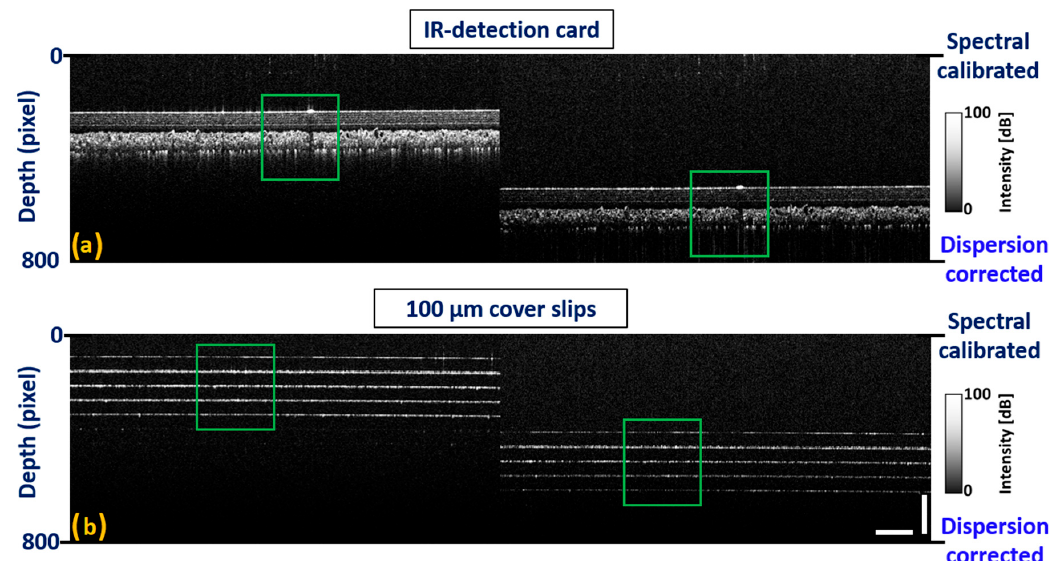
Figure 8. Spectrum calibrated two dimensional OCT images acquired after performing dispersion compensation. ( a ) 2D-OCT images of IR-detection card at top and bottom depth levels. ( b ) 2D-OCT images of five glass cover slips at top and bottom depth levels. Green color square boxes represent a region of interest with corrected dispersion. Horizontal scale bar: 1 mm, vertical scale bar: 300 μ m.